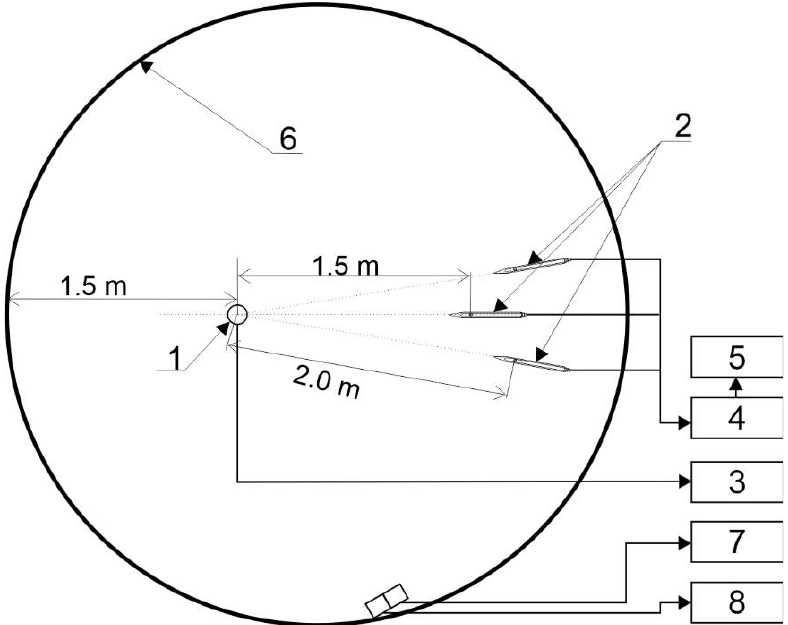
Figure 3. Diagram of the system for air blast waves overpressure and temperature measurement: 1 — explosive charge, 2 — pencil probes, 3 — time meter, 4 — signal conditioner, 5 — oscilloscope, 6 — the wall of the bunker, 7 — spectrometer, 8 — signal generator.